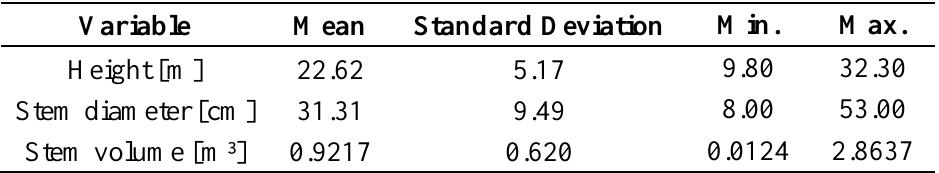
Table 4. Characteristics of the 178 identified pine trees.